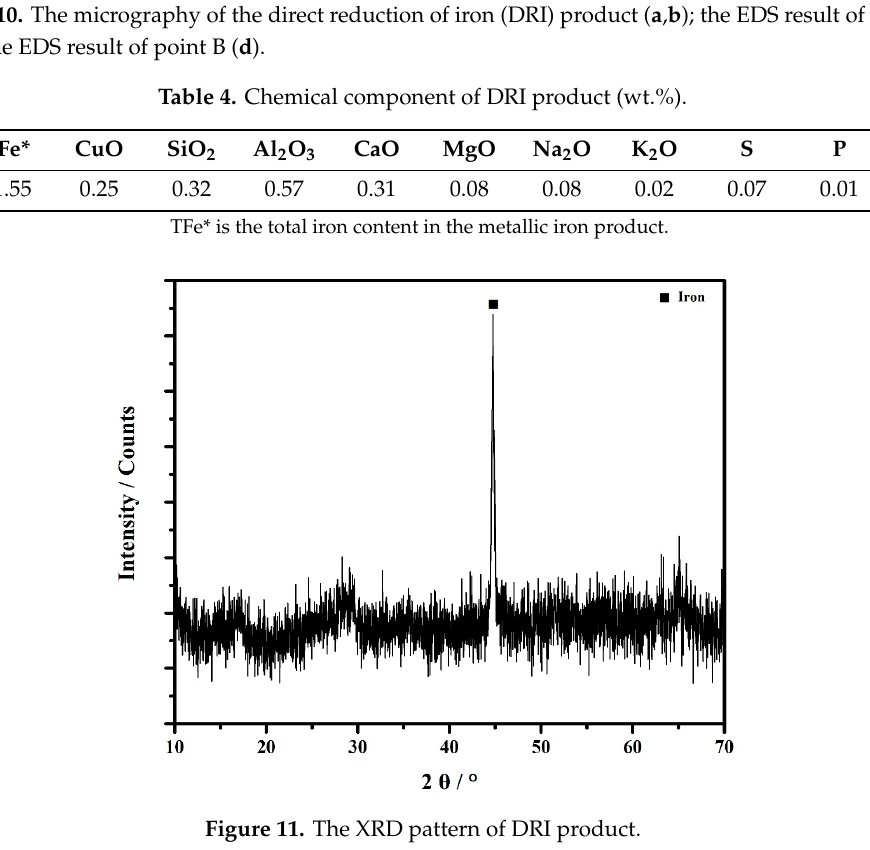
Figure 11. The XRD pattern of DRI product. Table 4. Chemical component of DRI product (wt.%).